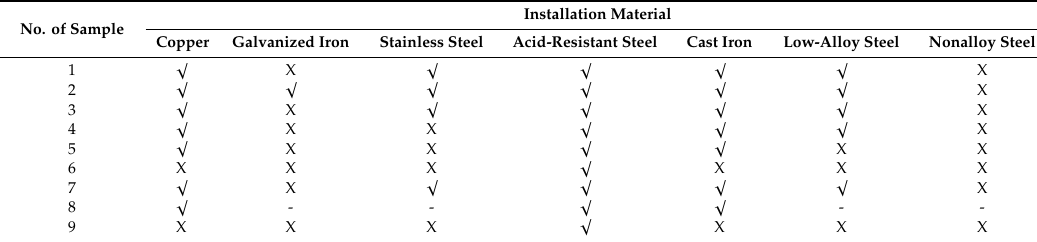
Table A3. Values for indices at which corrosion of individual installation materials will not occur—a snapshot of all the waters